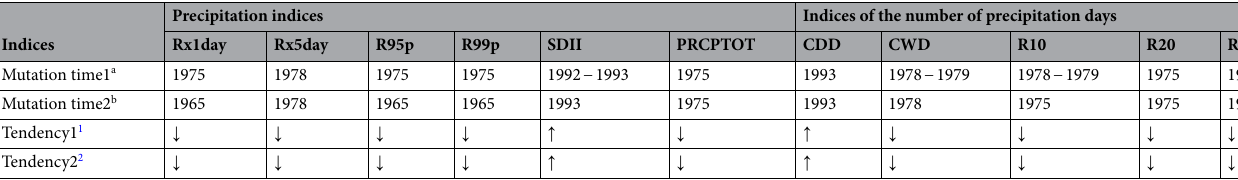
Table 3. Mutation time and trends of extreme precipitation indices in Shandong Province. a Mutation time1 and Tendency1 represents the results of extreme precipitation indices in this study. b Mutation time2 and Tendency2 represent the results of extreme precipitation indices in the coastal areas of Huanghuai, China (including Shandong